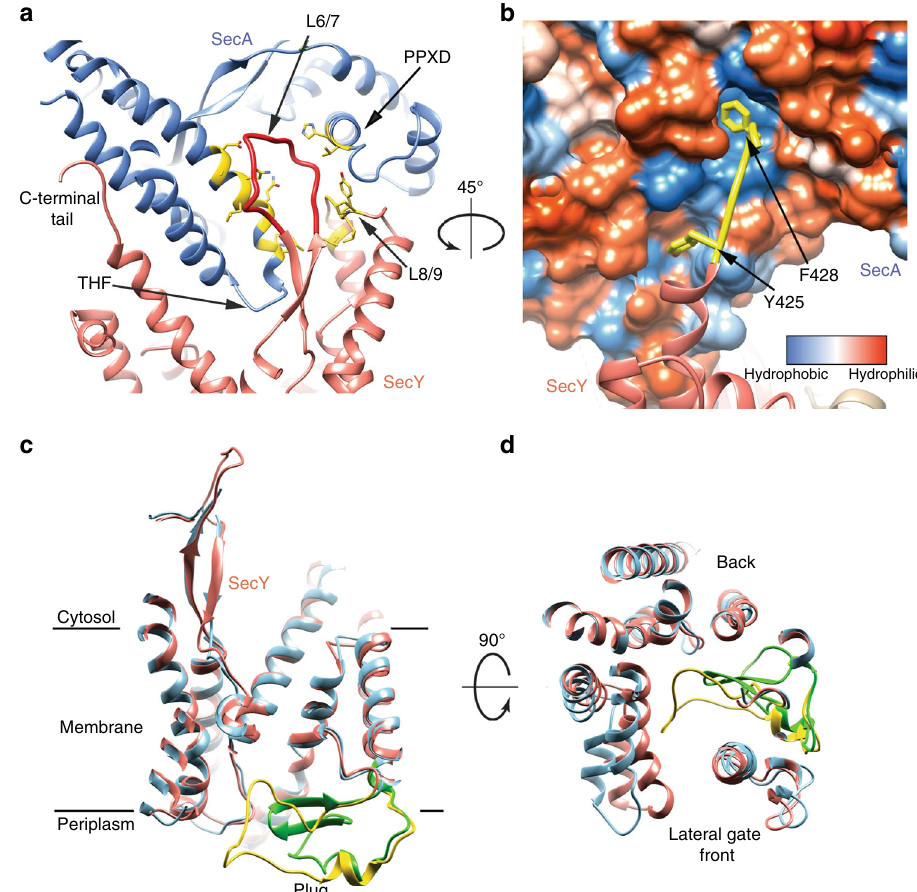
Fig. 2 The interaction between SecA and SecY and changes in SecY ’ s plug domain. a Interaction of the loop between TMs 6 and 7 of SecY (L6/7) (red) with the PPXD (blue), the THF, and the loop between TMs 8 and 9 (L8/9). The regions involved are colored yellow. b Interaction of the C-terminal tail (yellow) of SecY with SecA. SecA is shown as a space- fi lling model with residues colored according to their hydrophobicity. Interacting SecY residues are shown as yellow sticks. c Comparison between the plug regions in the cryo-EM structure and the crystal structure of SecA-OAins/SecY (PDB ID: 5EUL). The SecY molecule and plug are colored salmon and yellow, respectively, for the cryo-EM structure, and cyan and green, respectively, for the crystal structure. d Top view of ( c